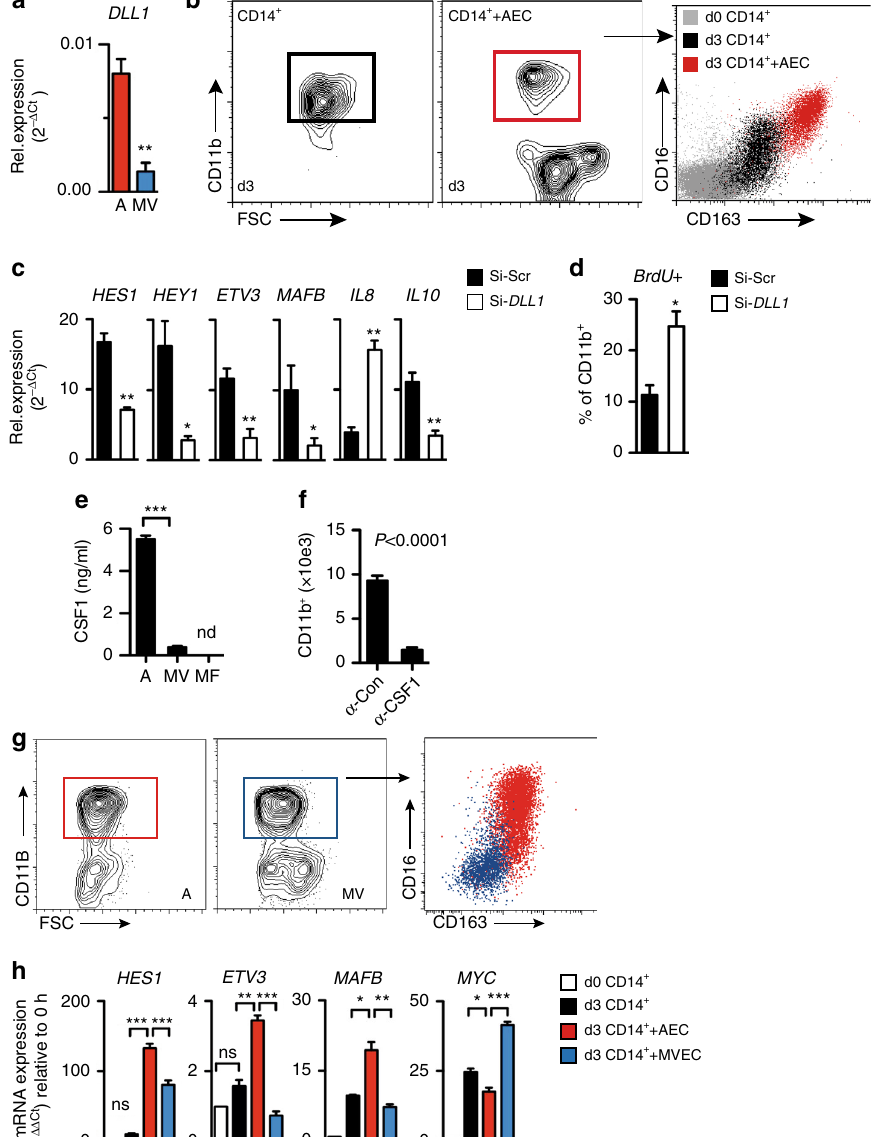
Fig. 4 Endothelial Dll1 instructs macrophage maturation in vitro. a Quantitative RT-PCR analysis of p3 primary human aortic EC (HAEC, A) or coronary microvascular (MV) EC. n = 3 independent samples in duplicates/group, error bars represent s.e.m., ** p < 0.01, Student ’ s unpaired t -test. b Representative fl ow cytometry from d3 culture of human CD14 + monocytes in the presence of 10 ng/ml M-CSF or HAEC (AEC). n = 4 independent experiments. c , d HAEC were transfected with anti- DLL1 siRNA (Si- DLL1 ) or scambled control (Scr) before co-culture with CD14 + monocytes. c . Quantitative RT-PCR analysis of CD11b + isolated from co-culture normalized to expression levels of input monocytes, n = 3 independent experiments, error bars represent s.e.m. ** p < 0.01, * p < 0.05, Student ’ s paired t -test. d BrdU incorporation (6 h) in CD11b + cells from co-culture, n = 3 independent experiments performed with duplicate measurements, error bars represent s.e.m. * p < 0.05, Student ’ s unpaired t -test. e Protein concentration of CSF1 in co-culture supernatants (A: arterial EC, MV: microvascular EC) or macrophage (MF) supernatants by ELISA, nd: not detectable. n = 3 independent experiments performed in triplicates, error bars represent s.e.m. *** p < 0.001 one-way ANOVA with Bonferroni post-test. f Number of CD11b + macrophages recovered after co-culture of CD14 + monocytes with HAEC treated with isotype ( α -Con) and CSF1 neutralizing ( α -CSF1) antibody. n = 2 independent experiments performed in triplicates, error bars represent s.e.m. p < 0.0001, Student ’ s unpaired t -test g , h Effect of HAEC (A) or MVEC (MV) on CD14 + monocytes. g Representative fl ow cytometry and pro fi le of gated population after d3 of co-culture. n = 3 independent experiments. h Transcriptional pro fi le of CD11b + cells isolated after 3d of culture with EC (A vs MV) or CSF1, normalized to expression levels of input monocytes (d0). n = 3 independent experiments, error bars represent s.e.m. *** p < 0.001, ** p < 0.01, * p < 0.05, one way ANOVA with Bonferroni multiple comparison